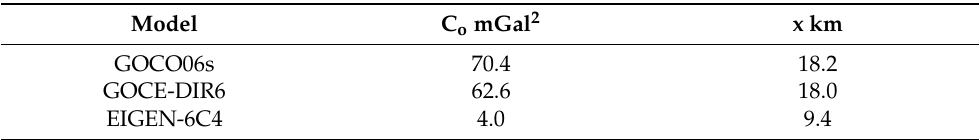
Table 2. Statistics of residual gravimetric anomalies (in mGal) calculated from different geopoten- tial models. Table 3. Parameters of the covariance functions of successive residual sets of gravity anomalies calculated from different geopotential